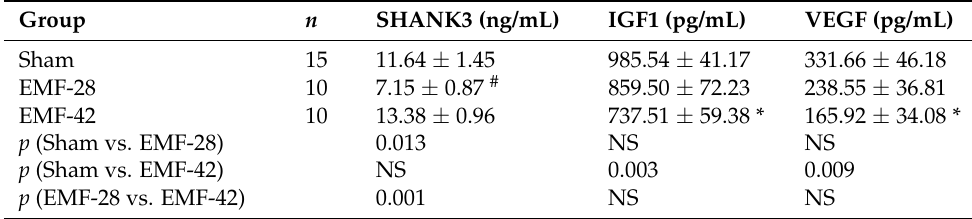
Table 4. SHANK3, IGF1 and VEGF levels of male rat pups’ testis (mean ± SEM).